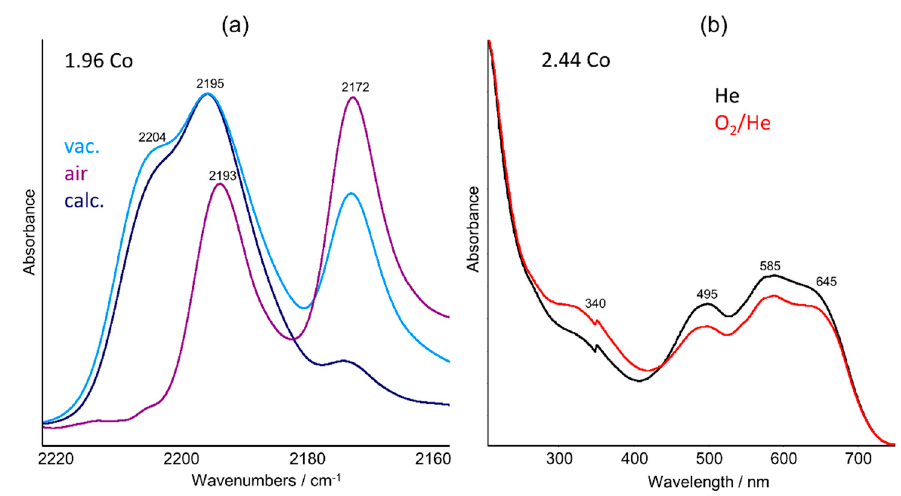
Figure 5. CO adsorbate normalized spectra measured at − 60 °C ( a ) of the samples 1.96 Co and ( b ) 2.44 Co.